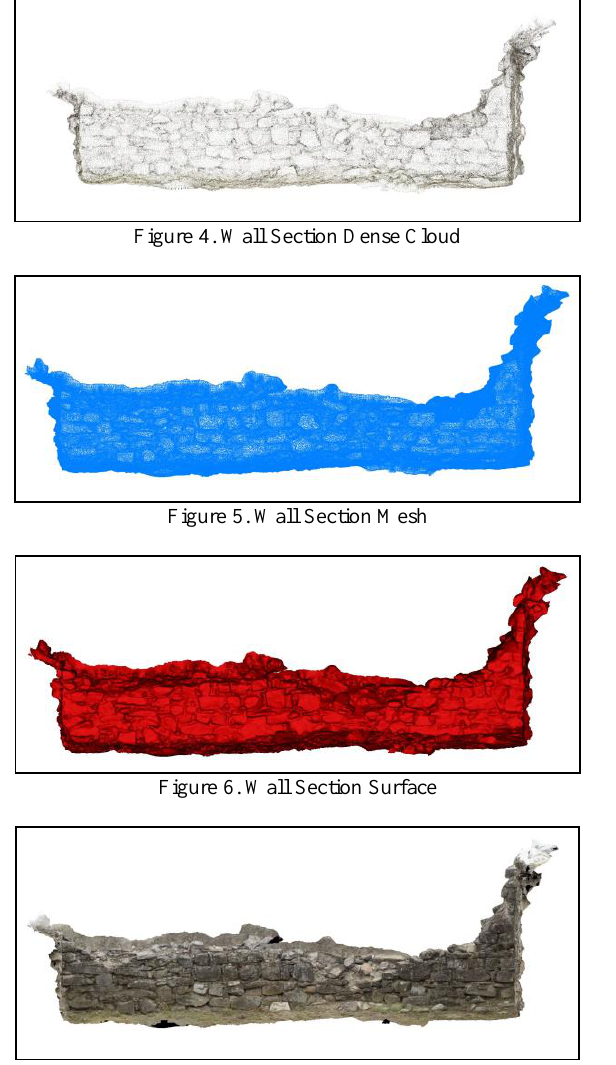
Figure 7. Wall Section Texture